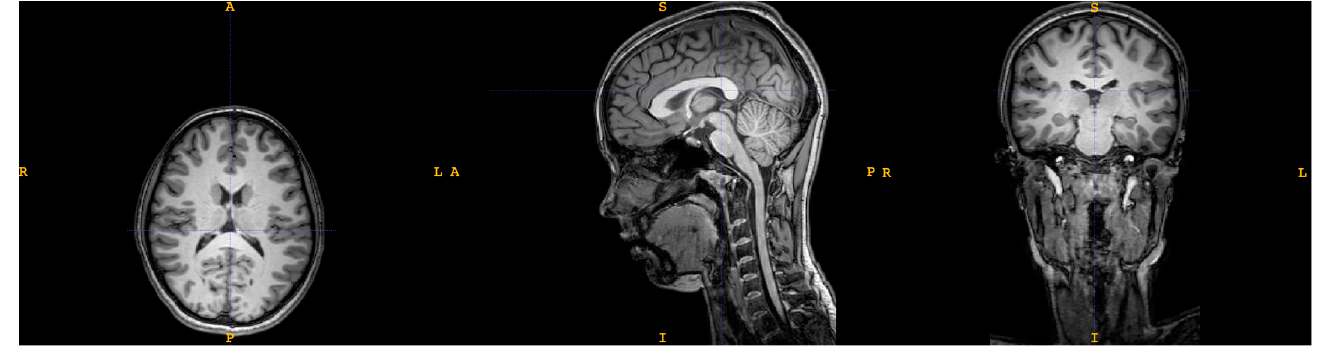
Figure 1. Example of T1 anatomical acquisition (axial, sagittal and coronal slices).